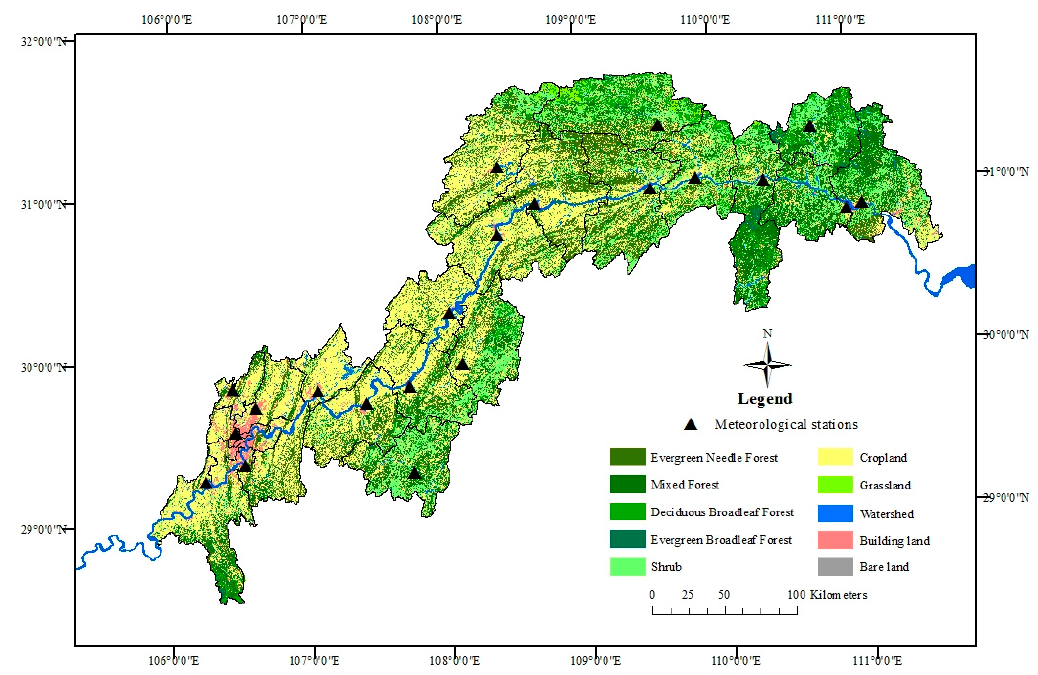
Figure 2. The distribution map of forest types in the TGRA in 2012 .